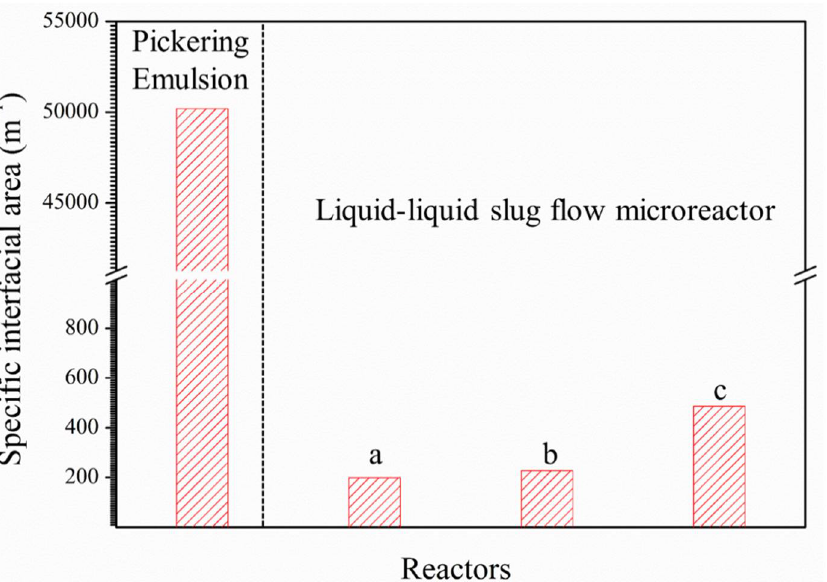
Figure 12. Calculated specific interfacial area of the dispersed phase in the Pickering emulsion and liquid–liquid slug-flow microreactors at different flow rates: ( a ) 0.02 mL/min, ( b ) 0.2 mL/min, and ( c ) 2.0 mL/min.